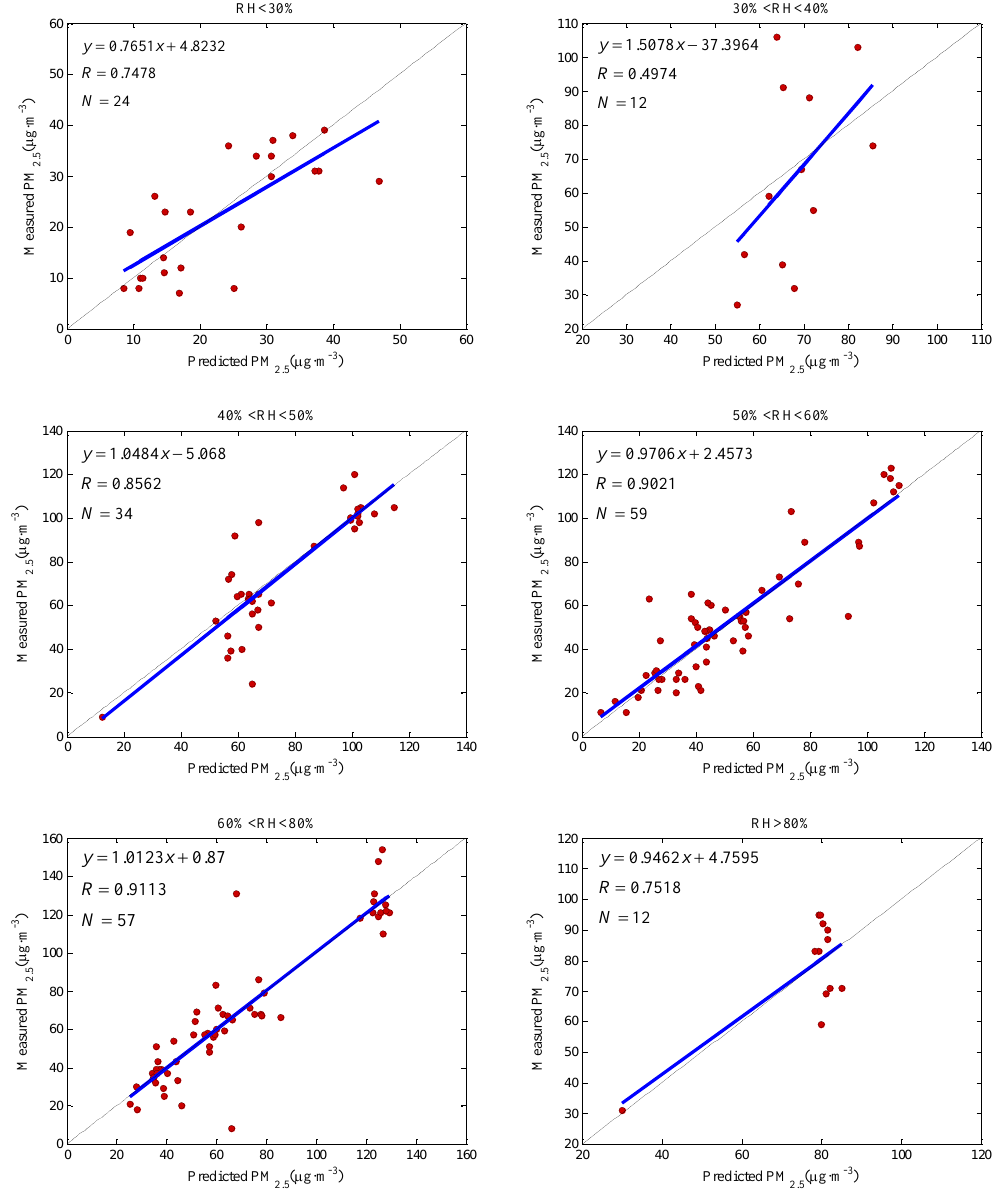
Figure 6. Correlation between PM 2.5 mass concentration predicted by the BP neural network model and measured by TEOM1405F as classified according to different relative humidity.